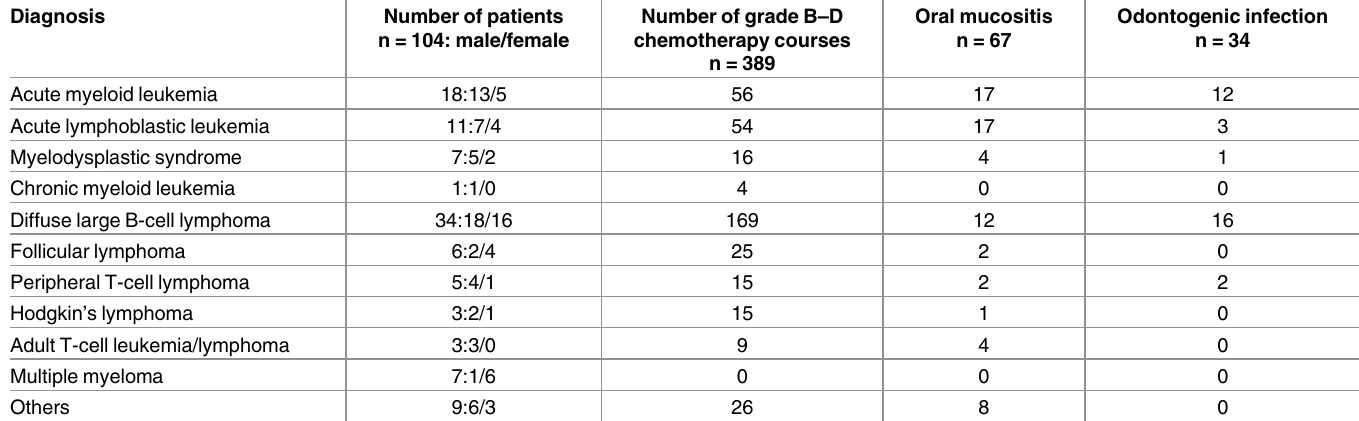
Table 1. Relationship between type of hematological malignancy and oral